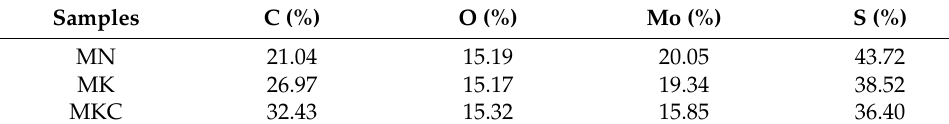
Figure 9. XPS wide ‐ scan spectra of coal samples: ( a ) MD, ( b ) MK, ( c ) MKC. Figure 9. XPS wide-scan spectra of coal samples: ( a ) MD, ( b ) MK, ( c ) MKC. Table 4. Surface chemical composition of coal samples (semiquantitative).